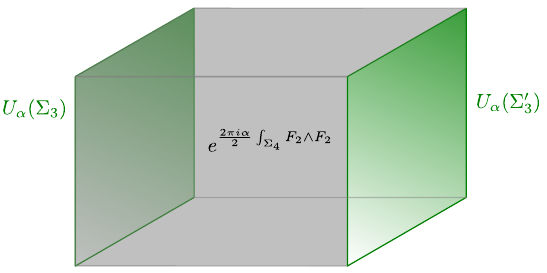
Figure 1 . A deformation of the naive operator U α (Σ 3 ) generates an anomalous phase in the region swept by